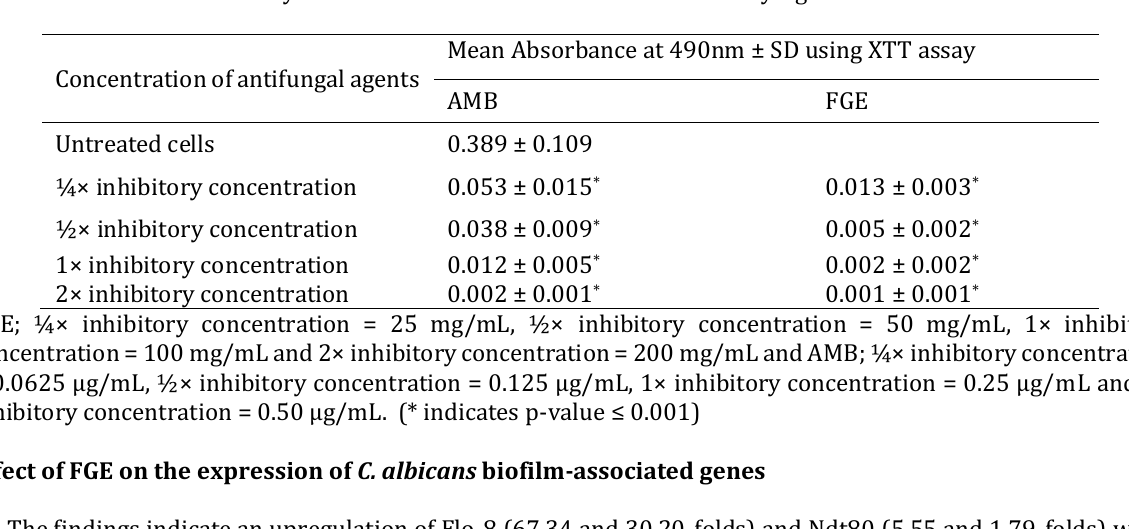
Figure 1: Anti-Candida properties exhibited by FGE through (A) agar well and (B) disc diffusion assay after 24 h. Zones of inhibition were visible in the areas surrounding the discs and the wells of 0.25 ug/mL of AMB (+ve control) and 100 mg/mL of FGE, respectively. Table 3: XTT assay of C. albicans biofilm when treated with varying concentrations of FGE.